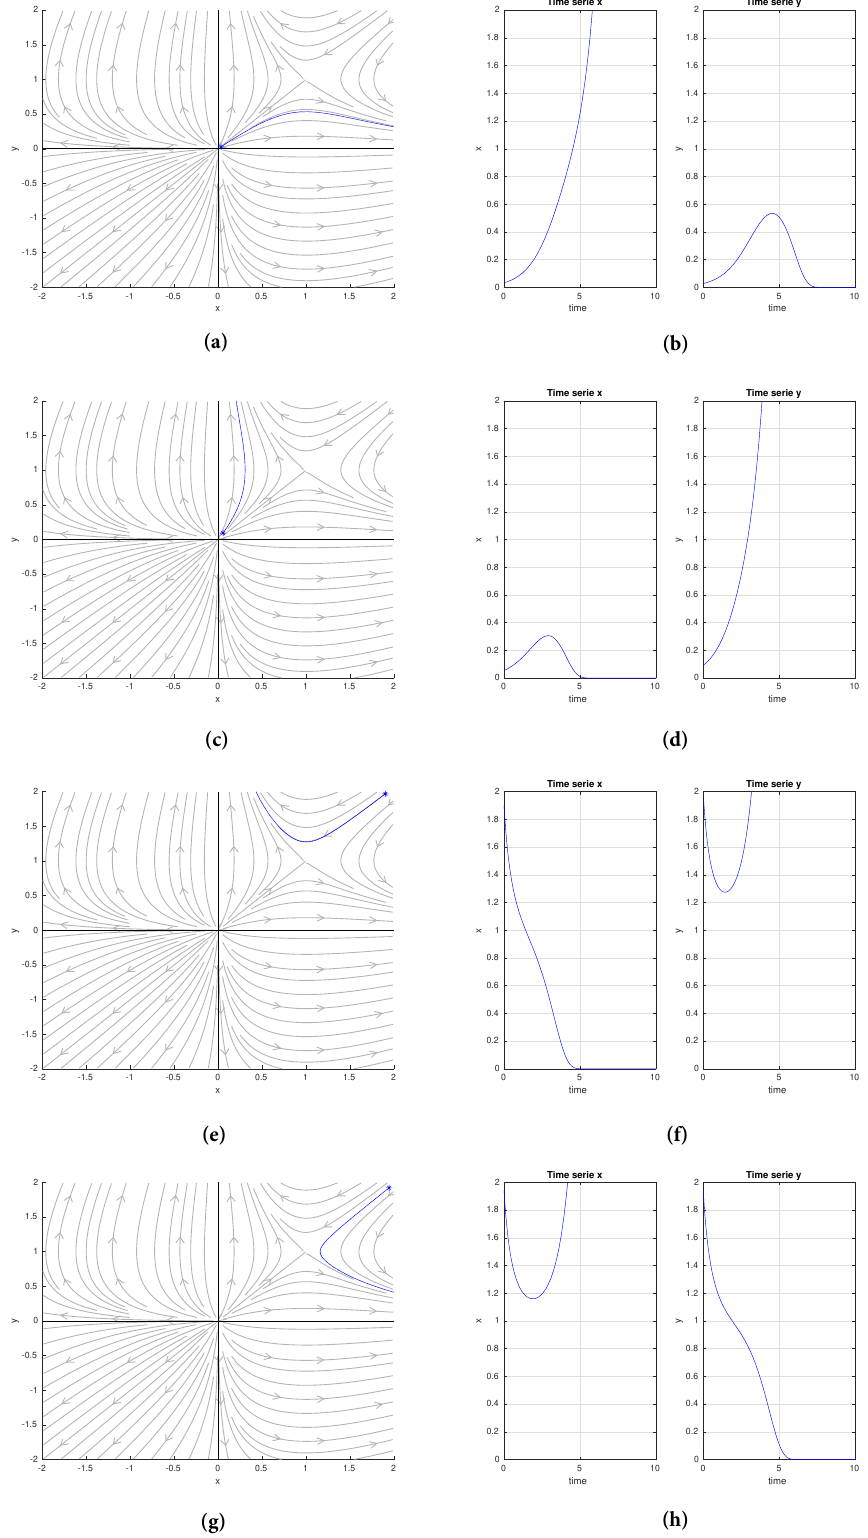
Figure 2. Case 1 simulations. This case occurs when vehicle entry rates are higher than exit rates in both categories. In ( a , b ), both technologies grow; however, finally, the conventional one dominates, while in ( c , d ), the opposite occurs. In ( e , f ), both technologies decrease, but the electric one manages to recover; while in ( g , h ), the opposite occurs.